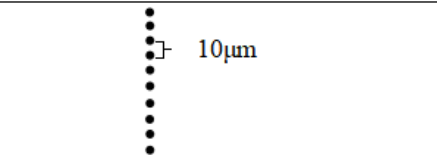
Figure 1. Schematic diagram of hardness test.